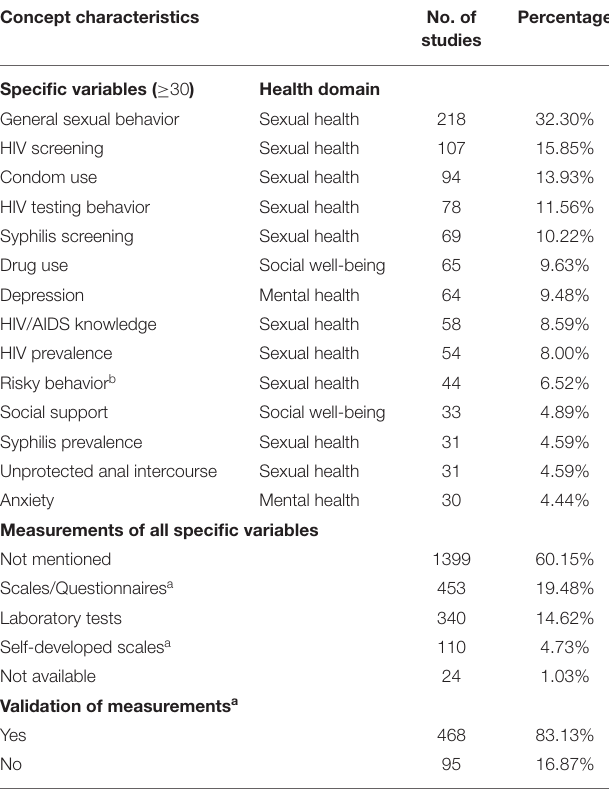
TABLE 7 | Specific health-related variables and corresponding measurements. Concept